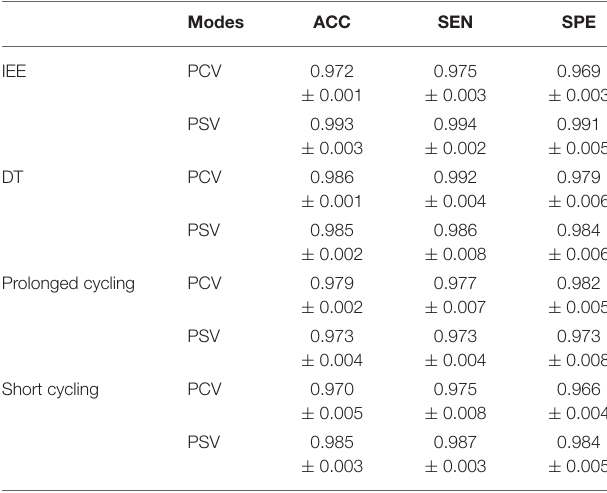
TABLE 3 | The performance of the PVA detection models under different ventilation